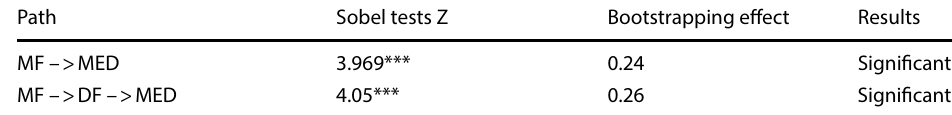
Table 7 Results of mediation